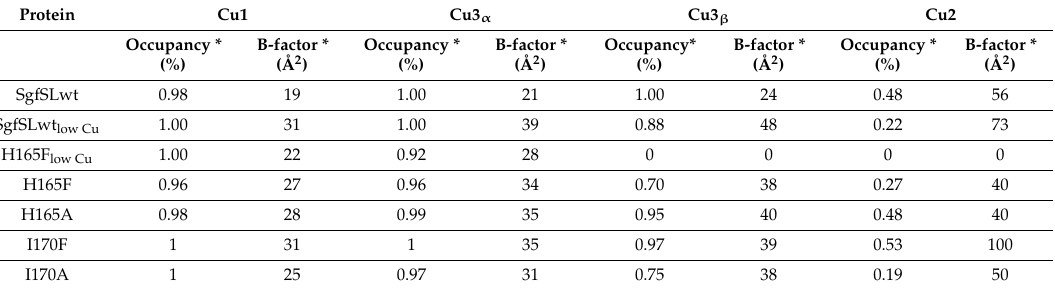
Table 2. Occupancy and B-factor of copper ions.